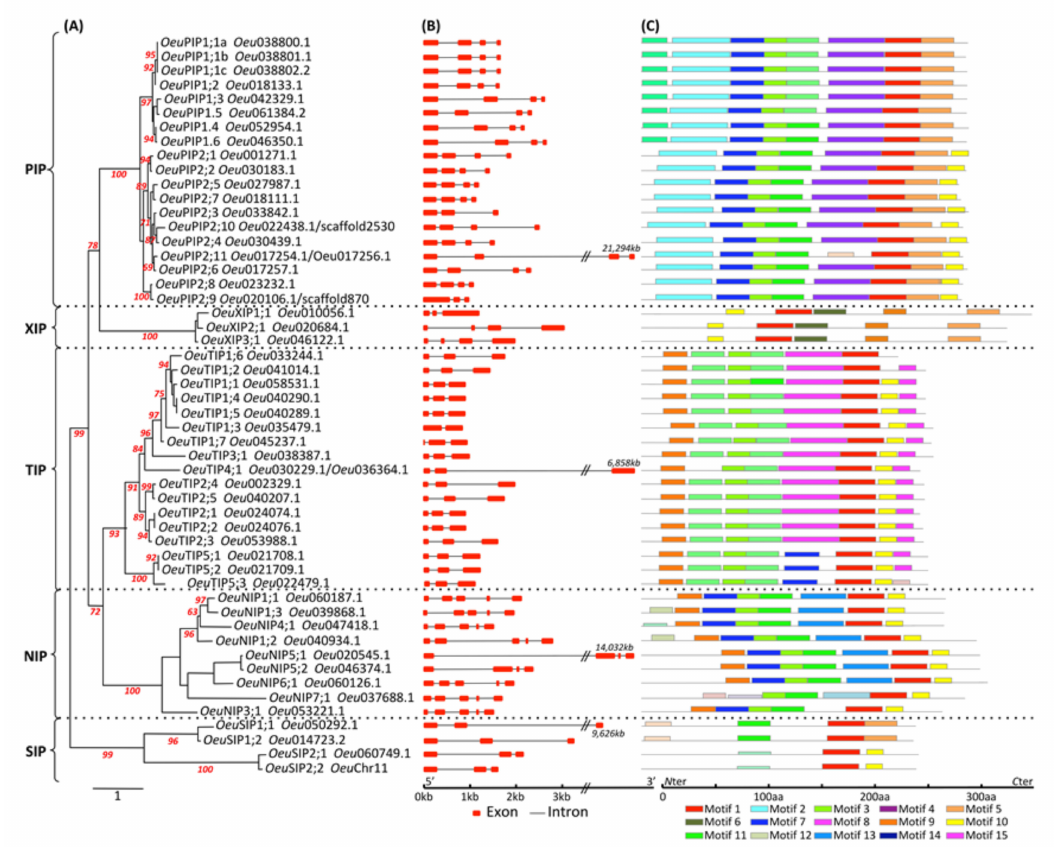
Figure 2. ( A ) Phylogenetic relationship, ( B ) Exon / Intron genomic structure, and ( C ) protein motif organization of the 52 full-length Olea europaea var. sylvestris aquaporin sequences. ( A ) Oleu AQP Sequences were aligned with MUSCLE, and the unrooted phylogenetic tree was reconstructed using the maximum likelihood method. The numbers at the nodes represent the percentage bootstrap values (only those 50% were represented). The reliability for the internal branch was assessed using 1000 bootstrap replicates. The distance scale denotes the number of amino acid substitutions per site. Oleu AQPs clustered into five AQP subfamilies: Oleu PIPs, Oleu XIPs, Oleu TIPs, Oleu NIPS and Oleu SIPs. ( B ) Exons and introns of the Oleu AQP genes are represented by red boxes and black lines, respectively. Gene structures were compared using GSDS software. Gene orientations are indicated (5 (cid:48) —3 (cid:48) ) in the x-axis. ( C ) Distribution of the conserved motifs among the Oleu AQP proteins. Motif analysis was performed by using the MEME web server. Fifteen conserved motifs were identified, and the di ff erent motifs are identified using di ff erent colored boxes, as indicated at the bottom of the figure. Each color block in the di ff erent proteins indicates a specific motif, for which the amino acids are detailed in Figure S6. Protein orientations are indicated ( N ter- C ter) on the